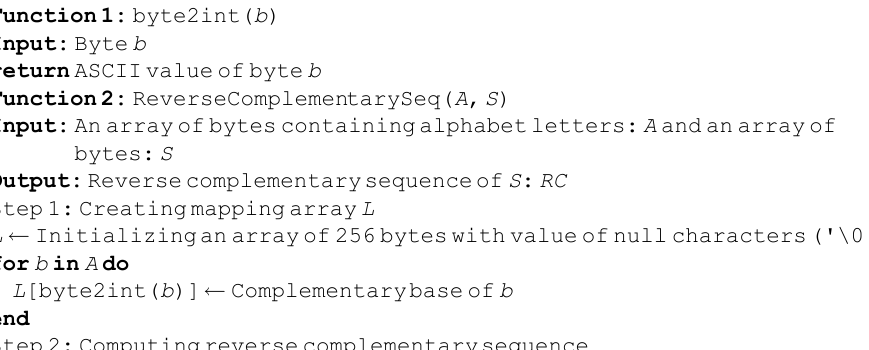
Algorithm 1: Fast reverse complementary